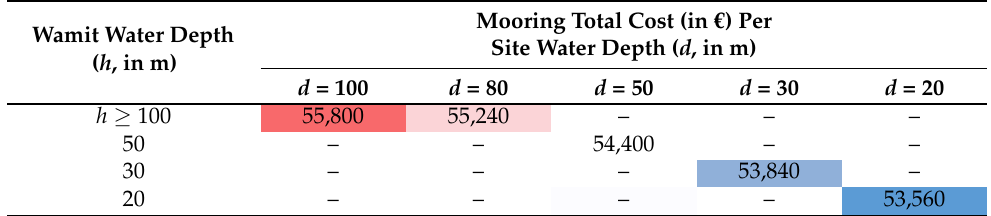
Table 10. Mooring cost—Equation (12)—in function of the relevant parameters. The darkest red cell is the highest value of the entire table, and the darkest blue reflects the lowest